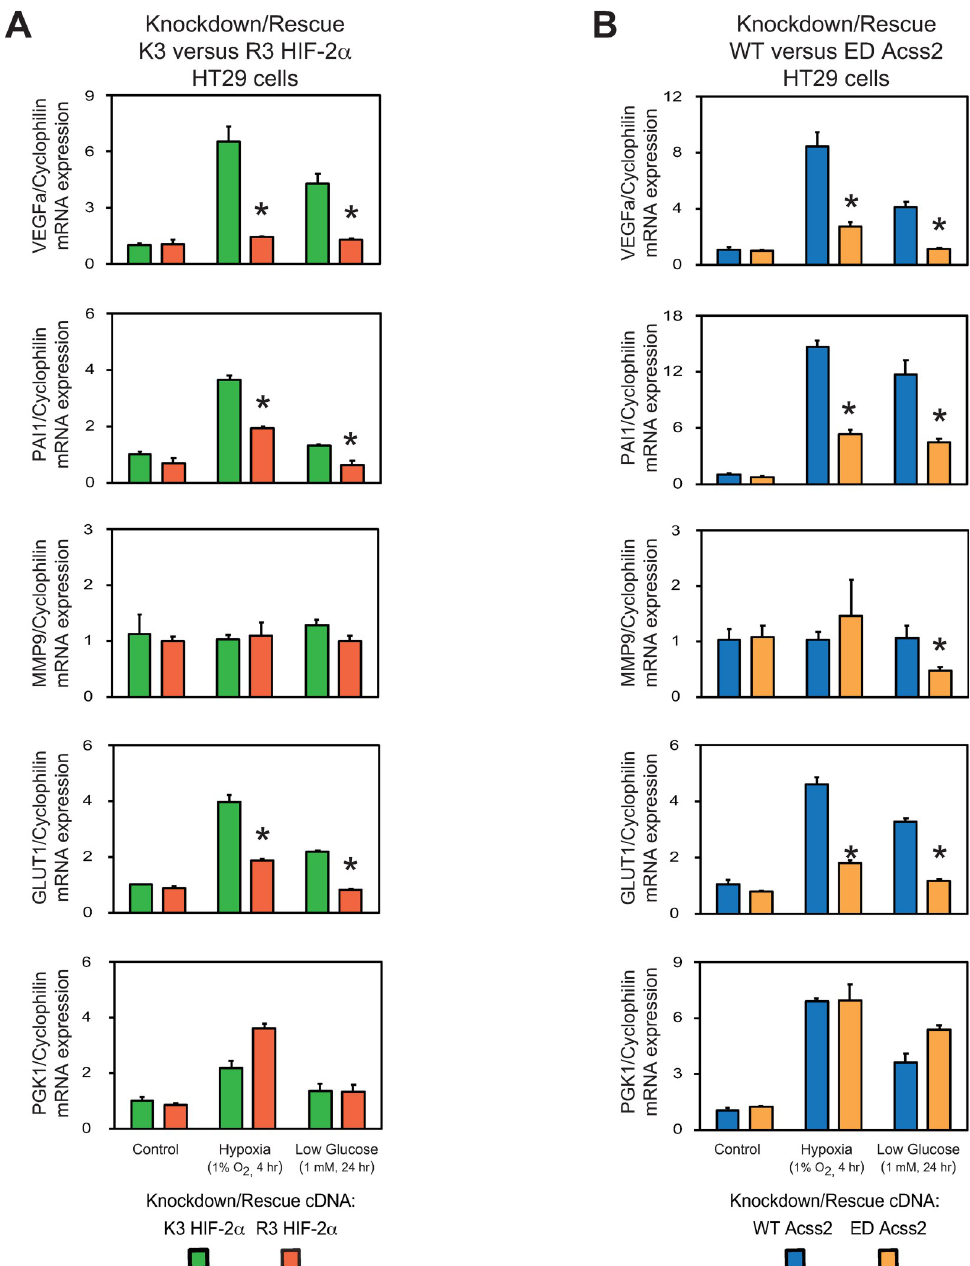
Fig 6. Acss2/HIF-2 regulates cancer-associated factors in HT29 cells. Semi-quantitative RTPCR measurements of HIF- 1 selective (PGK1) target genes in comparison with HIF-2 preferential or HIF-1/HIF-2 co-regulated (VEGFa, PAI1, MMP9, GLUT1) target genes in (A) HIF-2 α knockdown HT29 cells rescued with wild-type (K3) or arginine-lysine substituted mutant (R3) HIF-2 α , or (B) Acss2 knockdown HT29 cells rescued with wild-type (WT) or cytosol-restricted mutant (ED) Acss2, after the indicated period of hypoxia exposure or glucose deprivation. Comparison of samples within a given condition was performed by one-way ANOVA followed by Dunnett’s multiple comparisons test using control shRNA knockdown/control rescue as reference with decreased samples noted ( � , P < 0.05). Values indicated are means with SD.